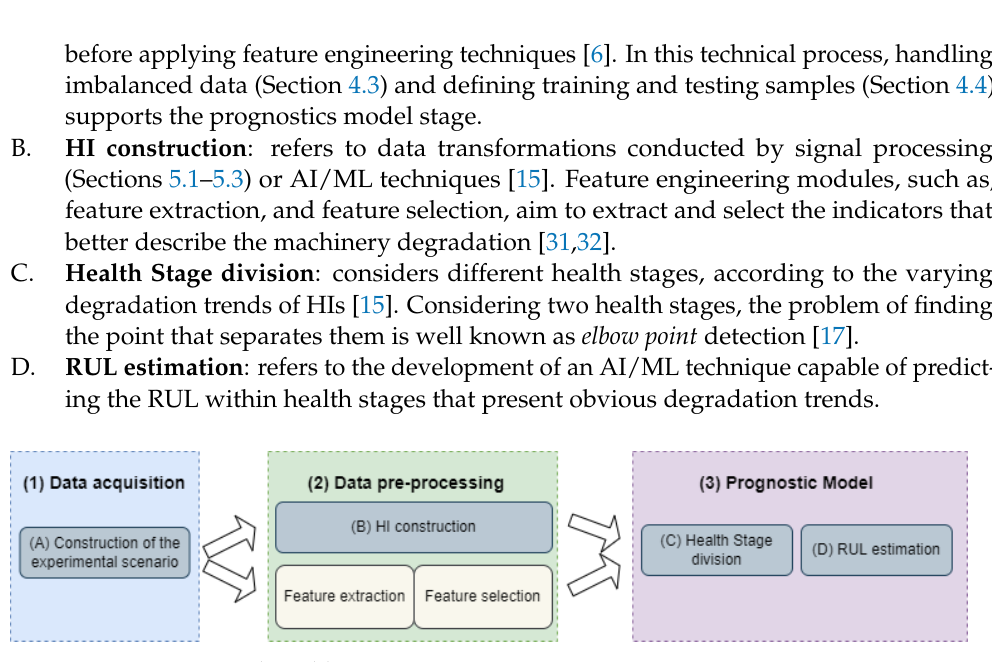
Figure 1. Prognostics and Health Maintenance